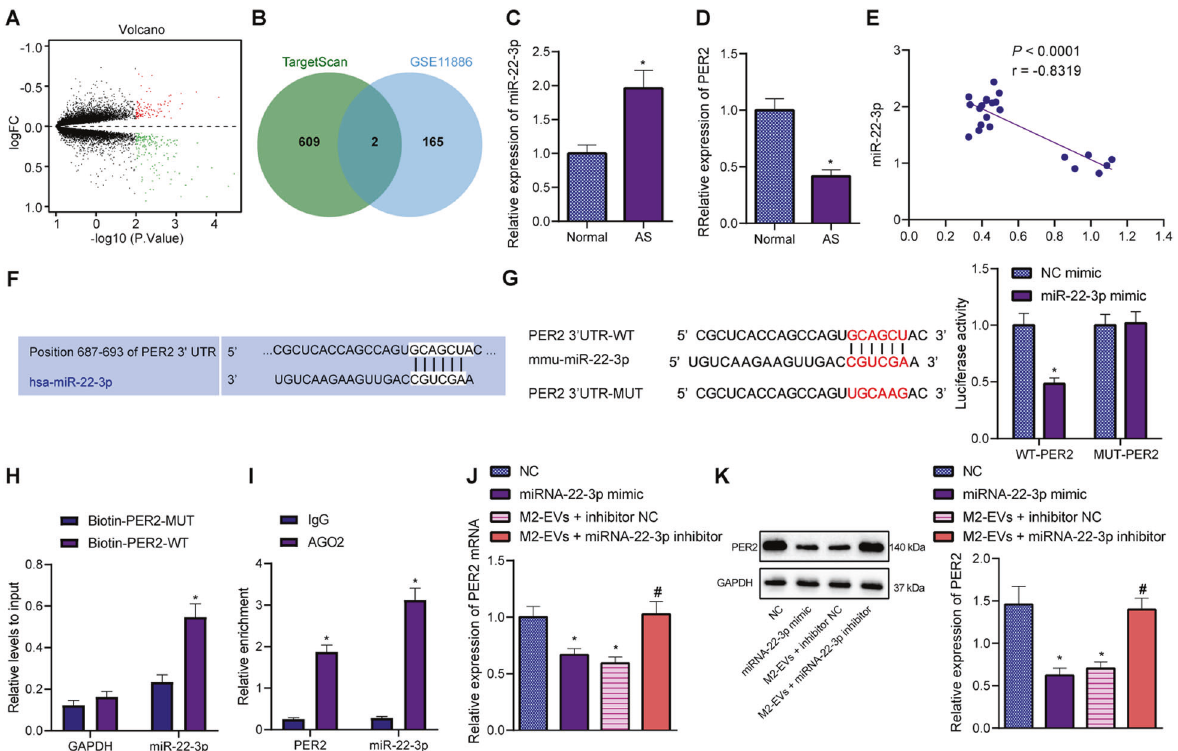
Fig. 3 The targeting relationship between miR-22-3p and PER2. A A volcano map of signi fi cantly differentially expressed mRNAs in normal samples ( n = 9) and AS samples ( n = 8) in the AS-related dataset GSE11886. B Venn diagram of potential target genes of miR-22-3p. The green circle represents the target genes predicted by TargetScan database, and the blue circle represents the downregulated genes in the GSE11886 dataset (9 normal samples and 8 AS samples). C Expression of miR-22-3p in normal spinal ligaments of patients with spinal fractures ( n = 6) and spinal ligaments of patients with AS ( n = 16) determined by RT-qPCR. D The mRNA expression of PER2 in the normal spinal ligaments of patients with spinal fractures ( n = 6) and spinal ligaments of patients with AS ( n = 16) determined by RT-qPCR. E The correlation between miR- 22-3p expression and PER2 expression in the spinal ligaments of patients with AS ( n = 16) analyzed by Pearson ’ s correlation coef fi cient. F The binding sites between miR-22-3p and PER2 predicted by TargetScan. G The target relationship between miR-22-3p and PER2 veri fi ed by dual- luciferase reporter gene assay. H Interaction between miR-22-3p and PER2 veri fi ed by RNA pull-down assay. I Enrichment of miR-22-3p and PER2 in cells incubated with AGO2 measured by RIP assay. J The mRNA expression of PER2 in the AS-MSCs treated with M2-EVs and/or miR-22- 3p mimic/inhibitor measured by RT-qPCR. K The protein expression of PER2 in the AS-BMSCs treated with M2-EVs and/or miR-22-3p mimic/ inhibitor measured by Western blot analysis. * p < 0.05 vs. normal spinal ligaments/biotin – PER2-WT/IgG/NC, # p < 0.05 vs. AS-BMSCs treated with M2-EVs + inhibitor NC. The cell experiment was repeated three times